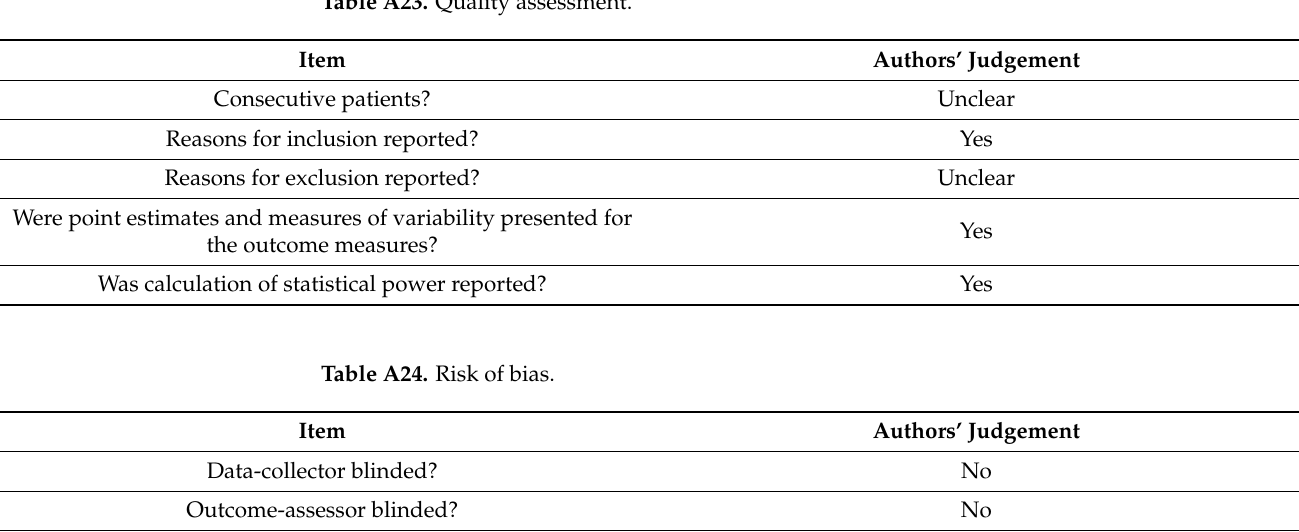
Table A23. Quality assessment.